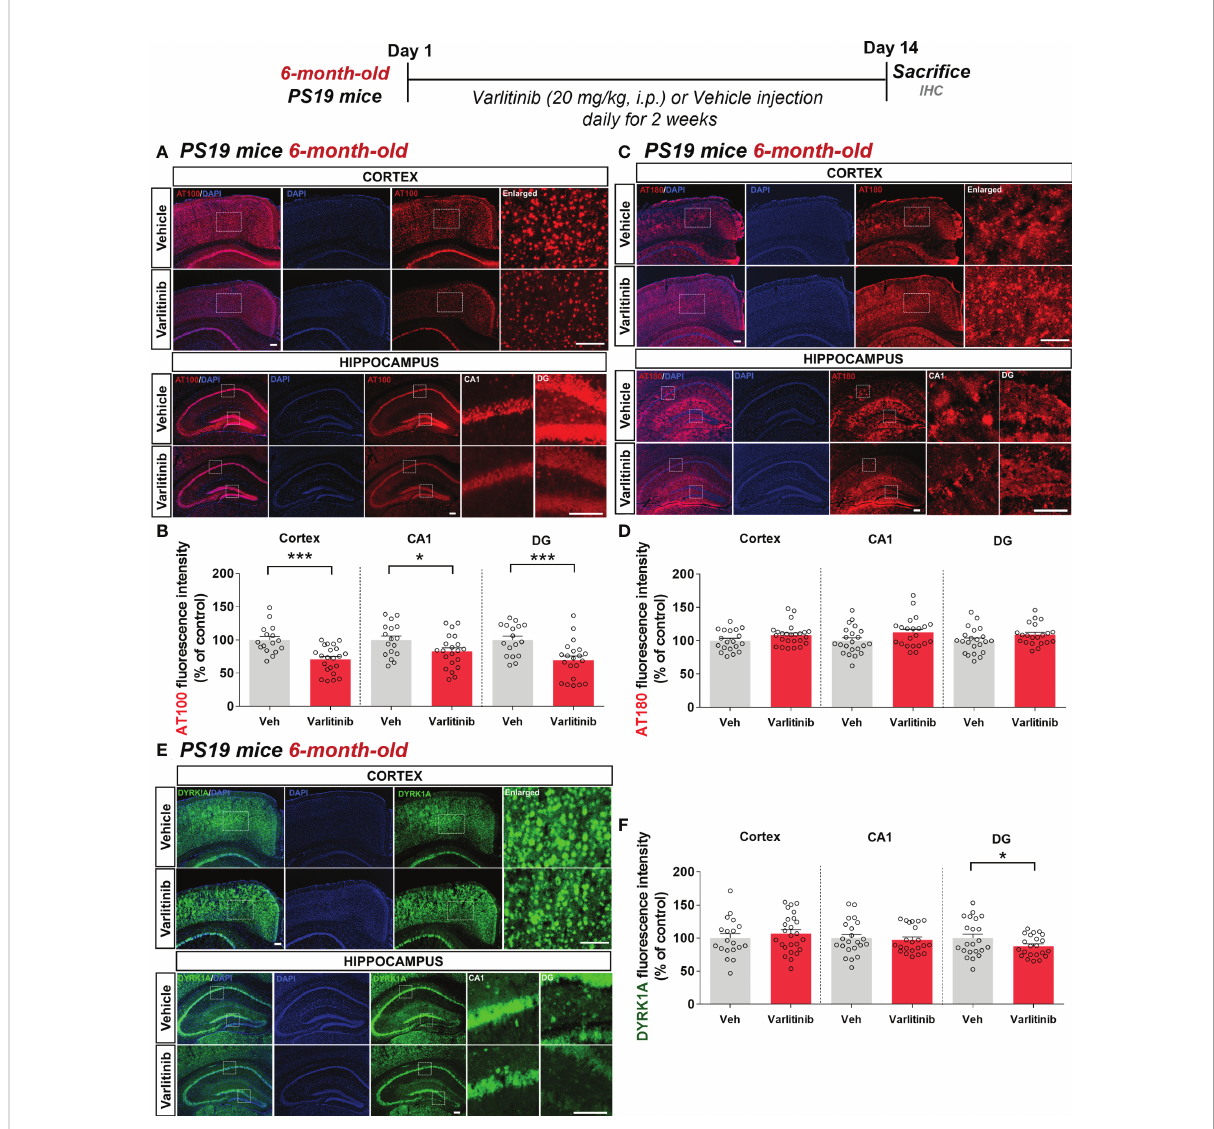
FIGURE 8 Varlitinib selectively diminishes tau phosphorylation in 6-month-old tau-overexpressing PS19 mice. (A, C, E) Six-month-old tau-overexpressing PS19 mice were injected with varlitinib (20 mg/kg, i.p.) or vehicle (5% DMSO, 10% PEG, 20% Tween-80, i.p.) daily for 14 days, and immuno fl uorescence staining was conducted with anti-AT100, anti-AT180, and anti-DYRK1A antibodies. (B, D, F) Quanti fi cation of data from (A, C, E) (n = 5 mice/group, AT100: Veh: 17 brain sections, Varlitinib: 21 brain sections; AT180: Veh: 17 brain sections, Varlitinib: 21 brain sections; DYRK1A: Veh: 17 brain sections, Varlitinib: 21 brain sections) * p < 0.05, *** p < 0.001. Veh, Vehicle. Scale bar=50 m